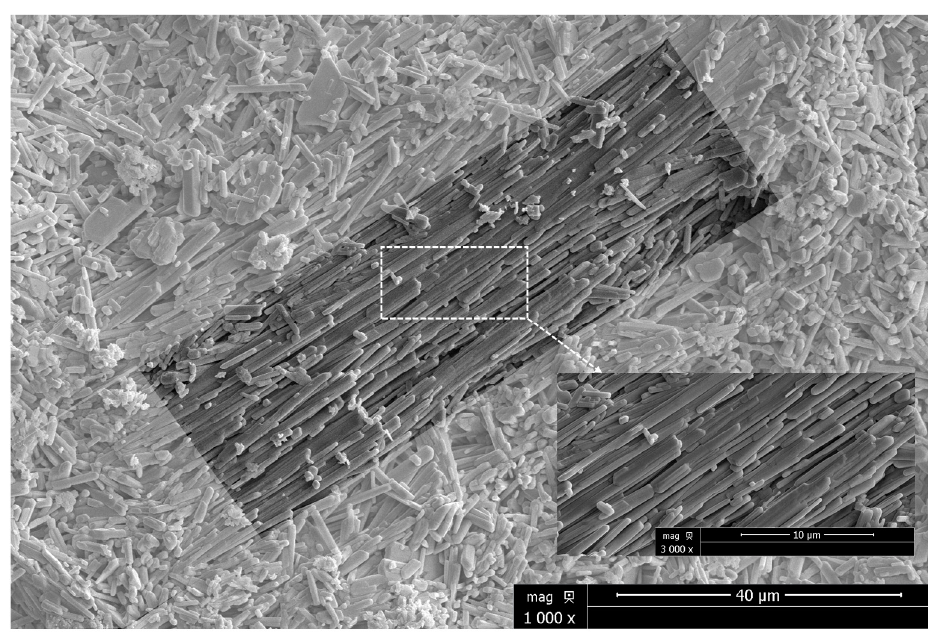
Figure 10. SEM scanning image of S2 (1000 times and 3000 times).